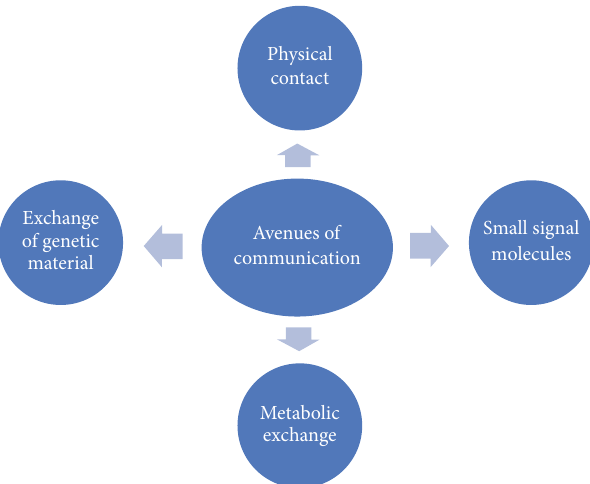
Figure 2: Showing various methods of communication among microorganisms in biofilm.